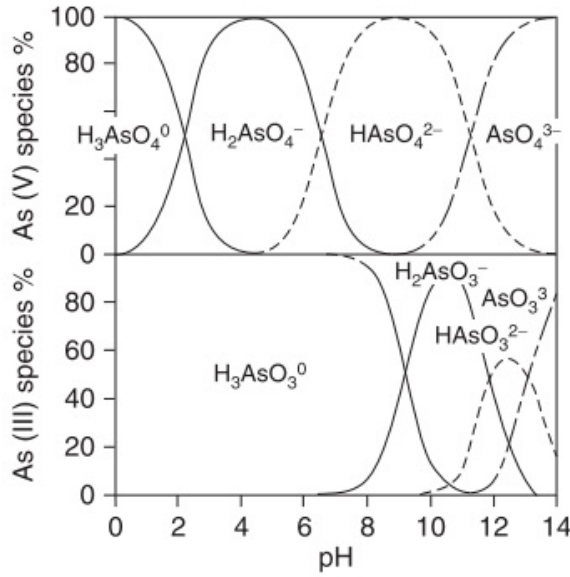
Figure 3. Distribution of As(V) and As(III) species as a function of pH, ionic strength = 0.04 M [43].